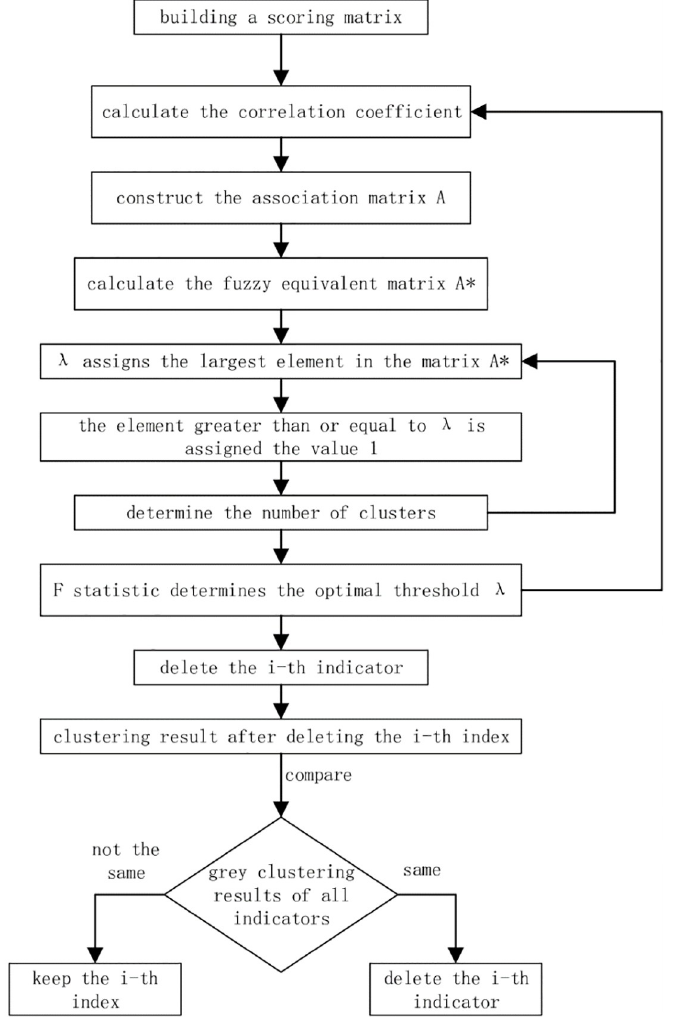
Fig 2. Indicator screening flow